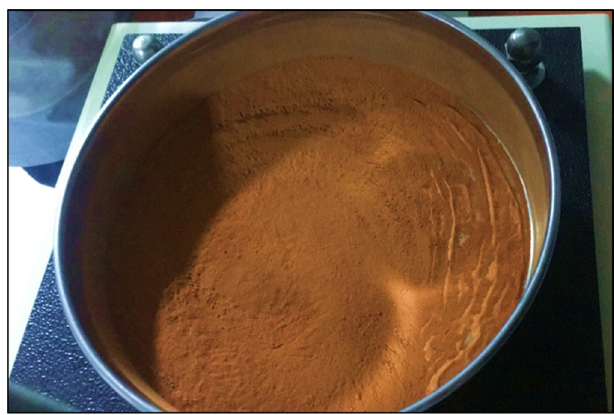
Figure 1. Clay ceramic waste (CCW).